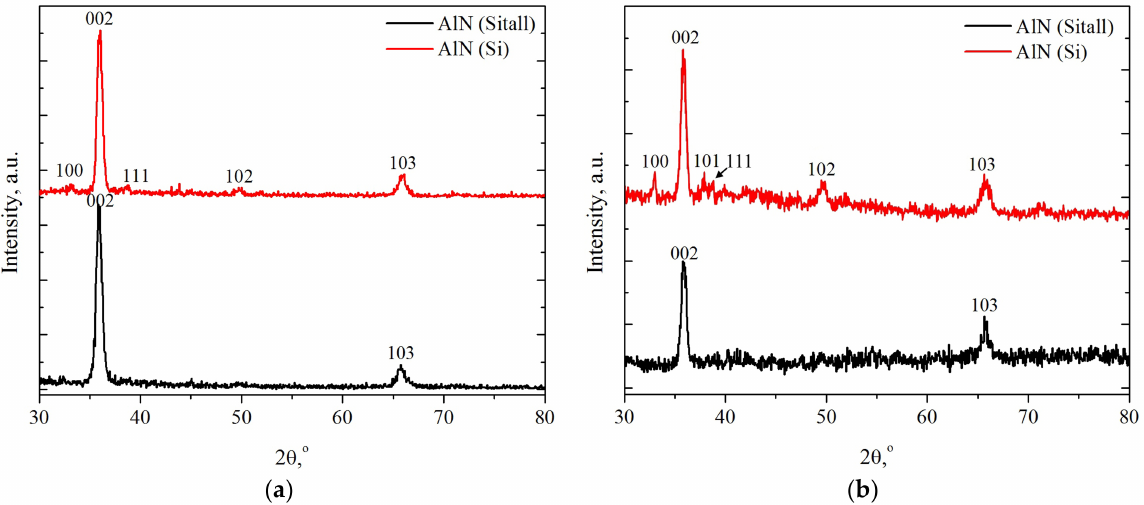
Figure 2. Comparative X-ray diffraction patterns of AlN films on Sitall (glass-ceramics) and Si substrates: ( a ) as-prepared; ( b ) after treatment with argon